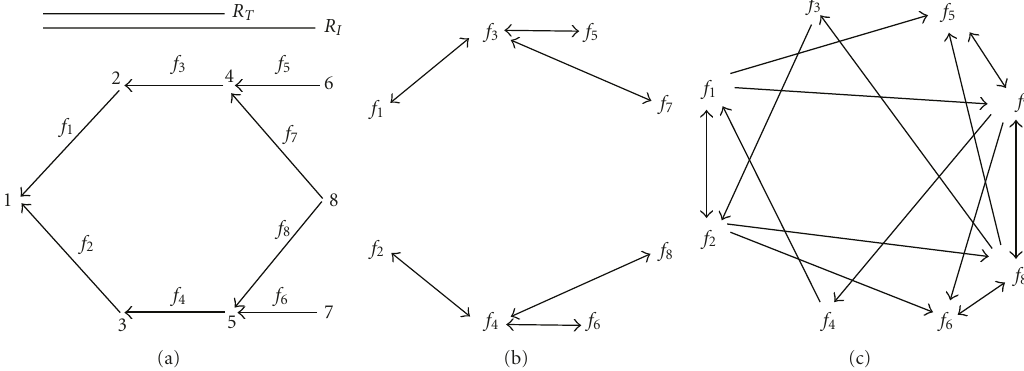
Figure 3: An example of weak and strong contentions: (a) the node topology graph G , (b) the corresponding strong contention graph G strong , and (c) the corresponding weak contention graph G weak